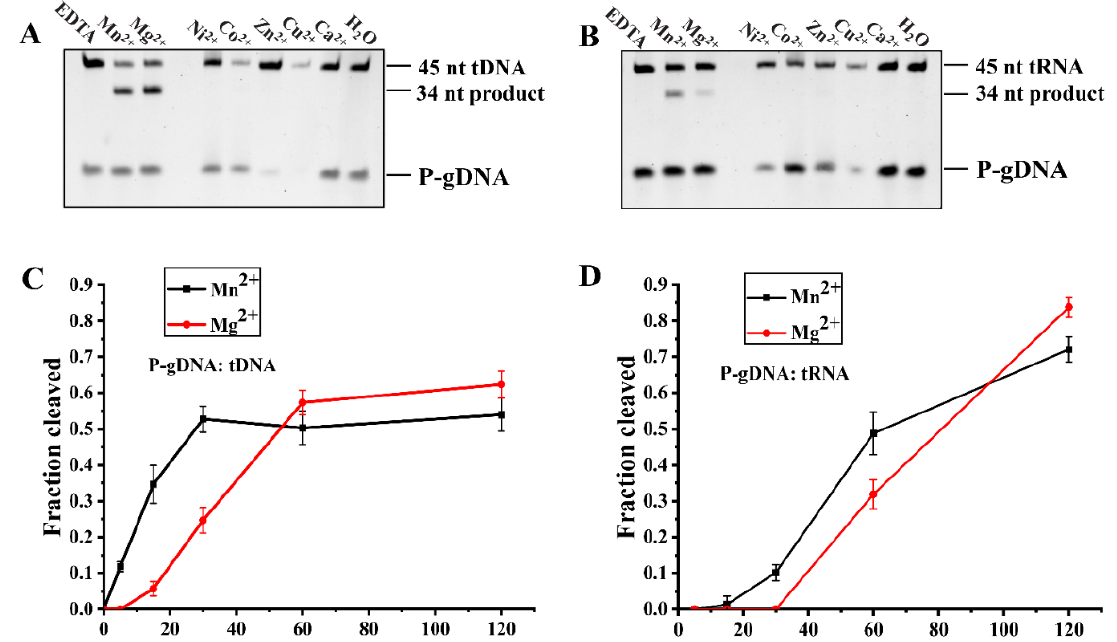
Figure 4. Effects of different divalent metal ions on RsuAgo cleavage activity. ( A ) Effects of different divalent metal cations on DNA target cleavage activity mediated by P-gDNA. ( B ) Effects of different divalent metal cations on RNA target cleavage activity mediated by P-gDNA. ( C ) Cleavage kinetics efficiency of DNA target mediated by Mn 2+ and Mg 2+ . ( D ) Cleavage kinetics efficiency of RNA target mediated by Mn 2+ and Mg 2+ . All experiments were performed at the 4:2:1 RsuAgo: guide: target molar ratio in reaction buffer containing different divalent metal ions for 1 h at 37 °C. All cleavage experiments were carried out in triplicates and quantified. Error bars represent the SD based on three independent experiments.